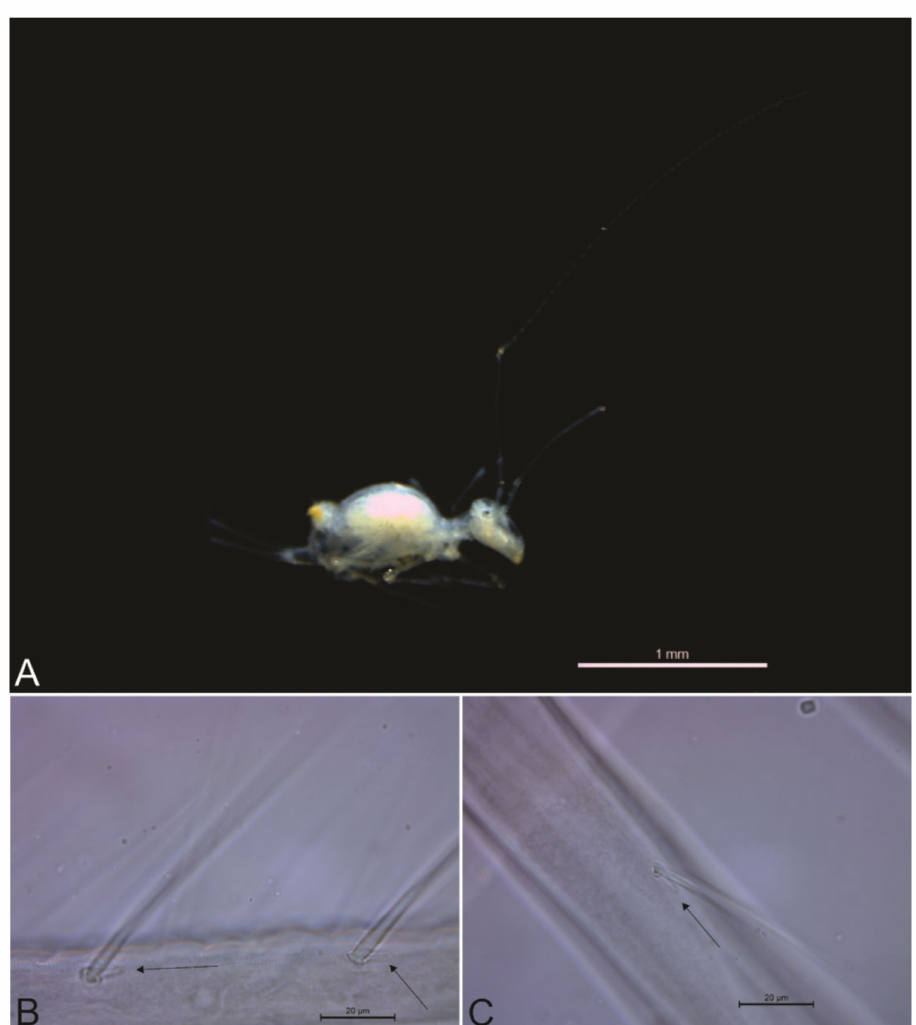
Figure 3. Troglobentosminthurus luridus gen. nov. sp. nov. morphology: ( A ) habitus of a fixed specimen in ethanol; ( B ) two chaetae elongate alveoli on the dorsal dens (marked with black arrows); ( C ) one chaeta elongate alveolus on the tibiotarsus II (marked with a black